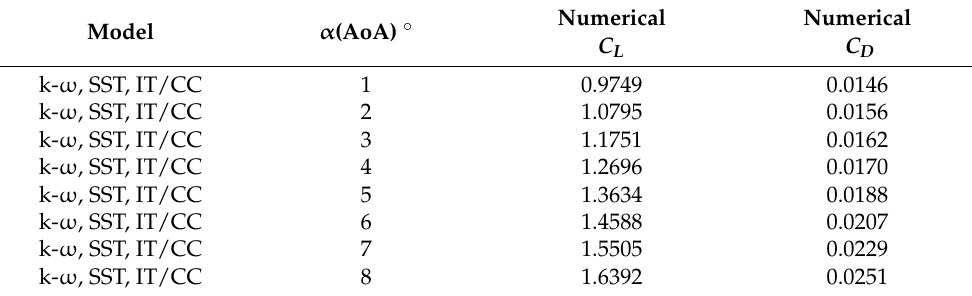
Table 5. NACA8410 simulated results.